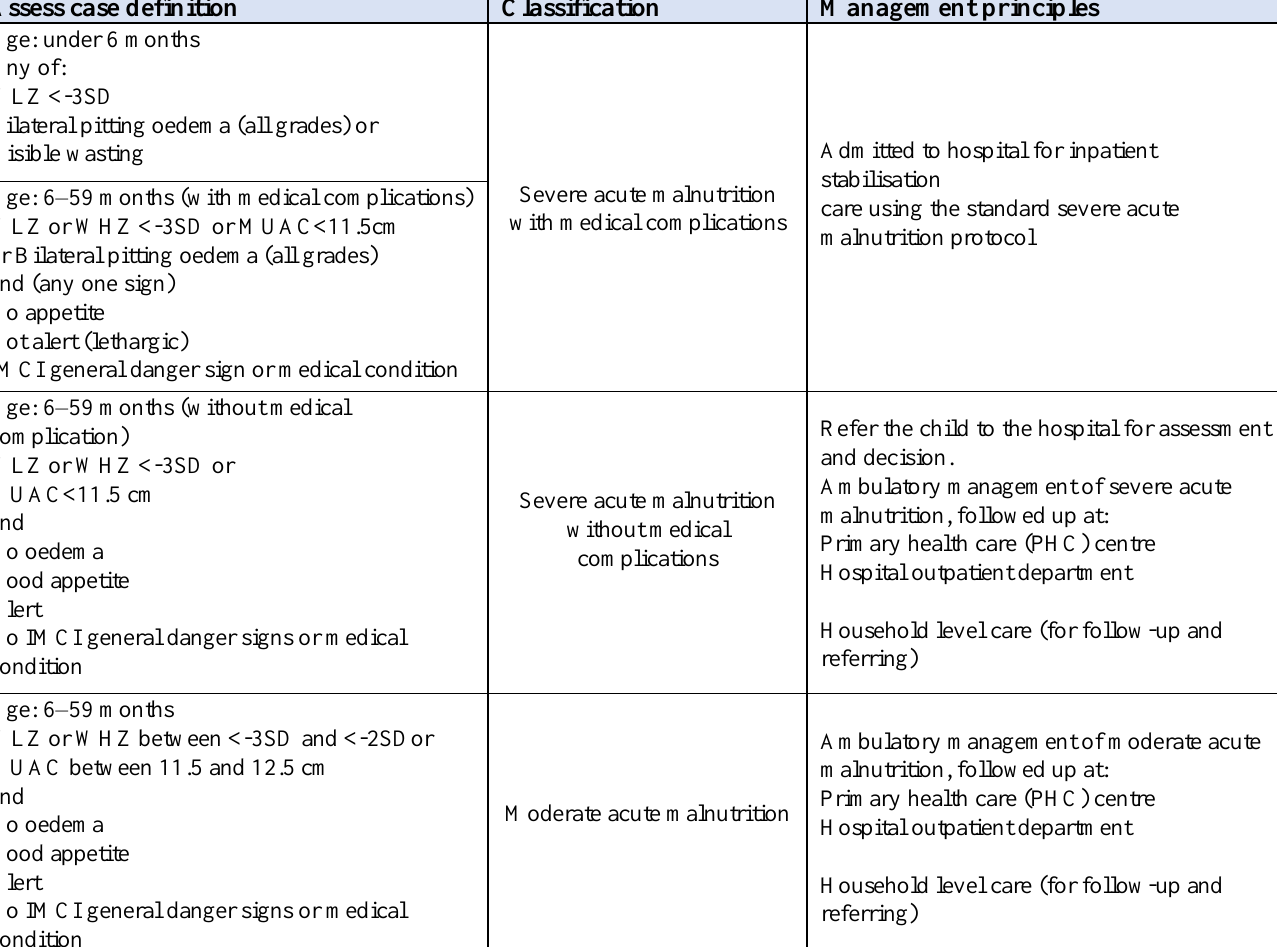
Table 1. Classification of SAM based on age, medical complications and management principles Assess case